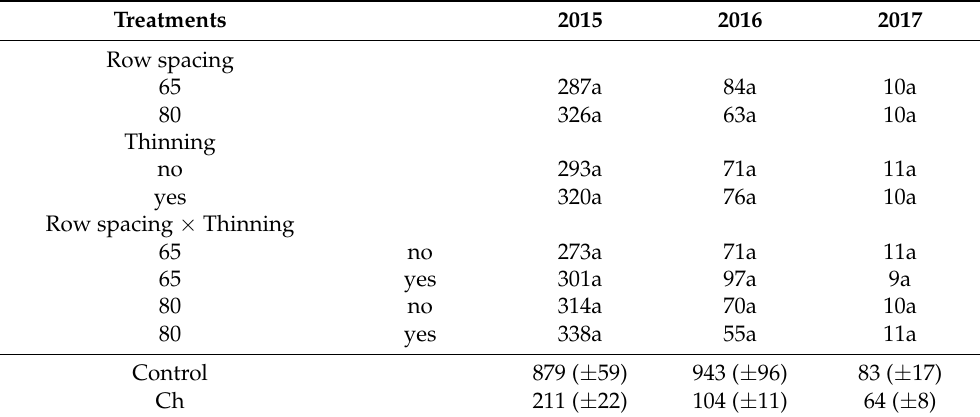
Table 1. Mean numbers of black bean aphid (all morphotic forms) per one broad beans plant in the 2015–2017 seasons.